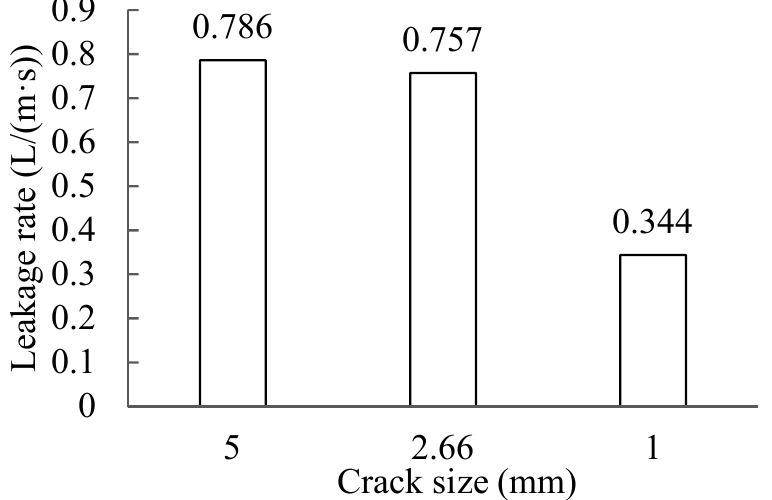
Figure 9. Comparison of leakage rate with different crack sizes.